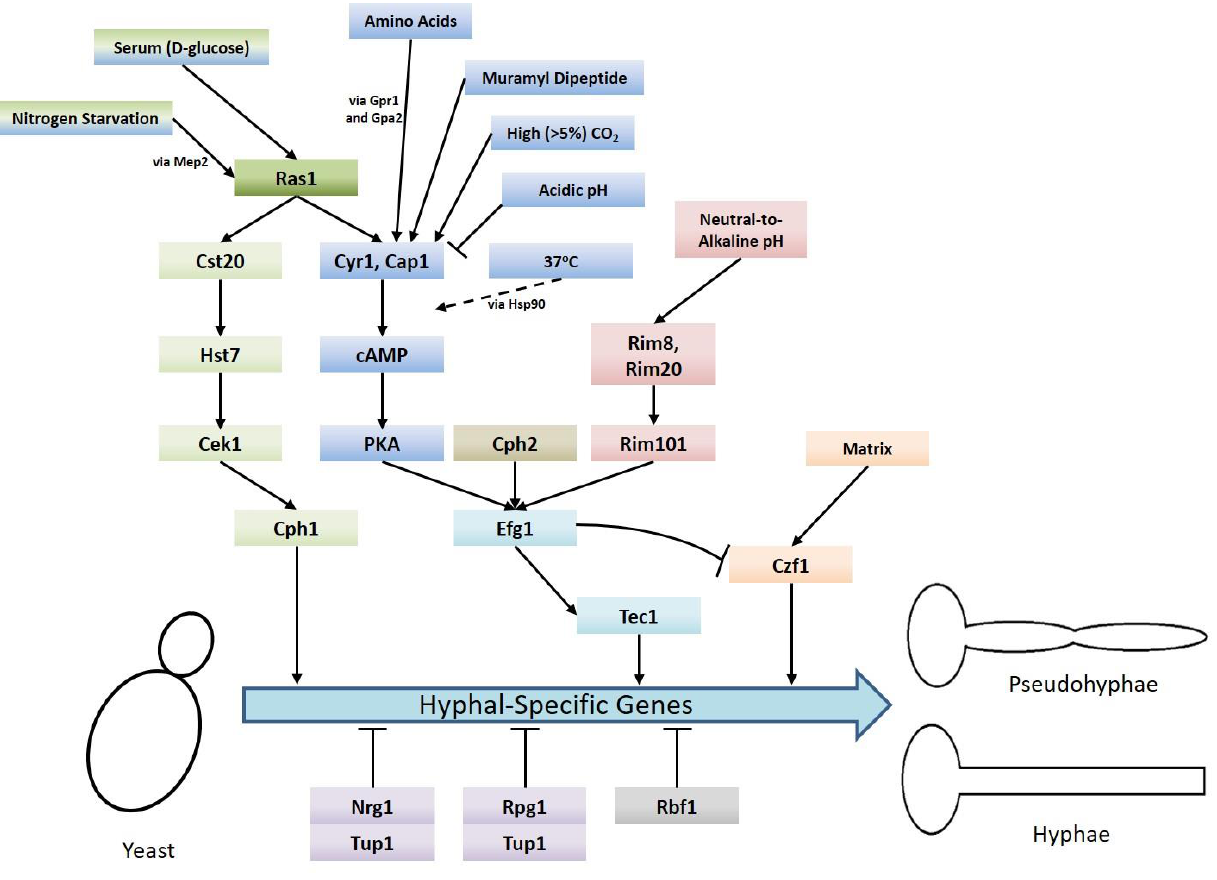
FIGURE 1: Summary of the signalling pathways and stimuli which regulate the yeast-to-hyphae morphogenic switch in Candida albicans . Several different pathways are responsible for inducing the yeast-to-hyphae switch: MAP kinase pathway (green), Cyr1-PKA pathway (blue), pH response pathway (red), and matrix response pathway (orange). There are also two pathways which negatively regulate the switch: Tup1-Nrg1-Rpg1 pathway (purple) and Rbf1 pathway (grey). The signalling pathways that engaged in response to different conditions to regulate the yeast-to-hyphae morphogenic switch in C. albicans are also